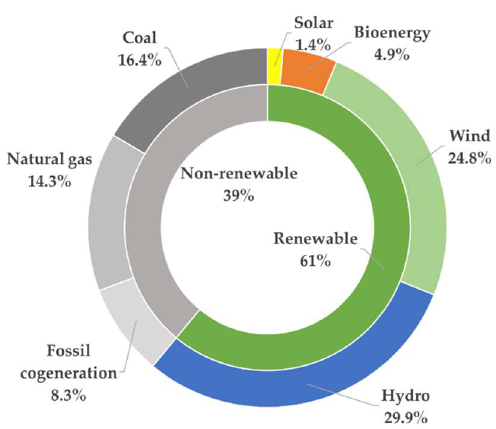
Figure 4. Portugal’s electric energy matrix [10].